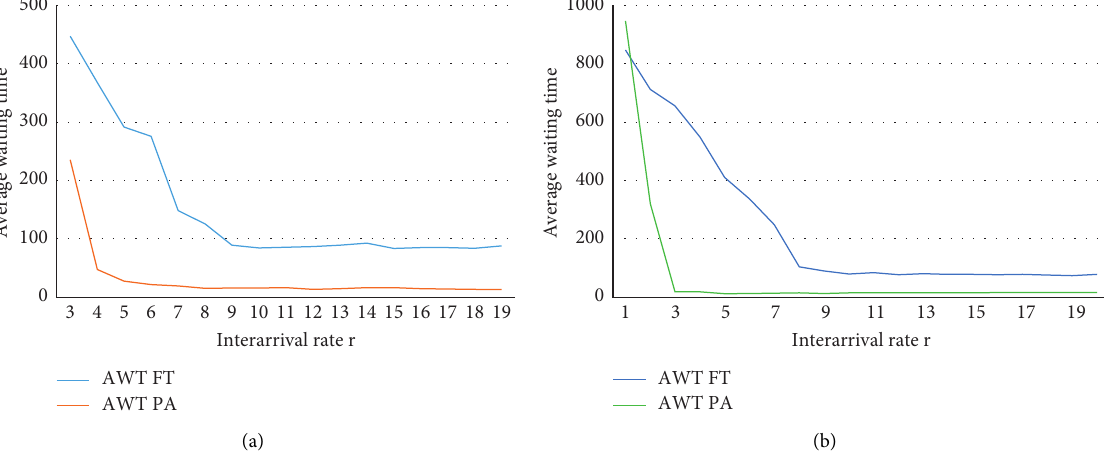
Figure 12: Average waiting time (AWT) in seconds using the fixed-time (FT) and the proposed algorithm (PA) when varying the rates of one road. (a) Different constant rates on the other three roads (10, 15, 20), (b) All the other roads have the same rate